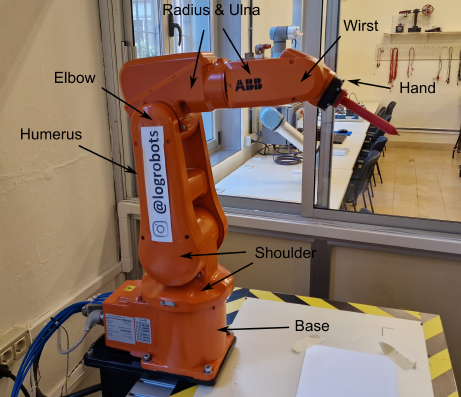
Figure 1. Equivalence between robot and human